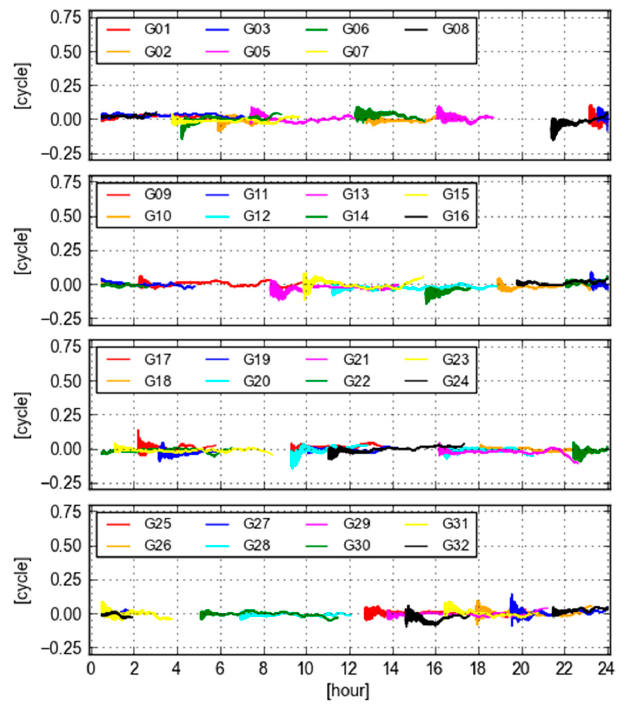
Figure 5. Differences of GB and GF WL ambiguities computed with ESA final orbit and clock products at site KOKV.